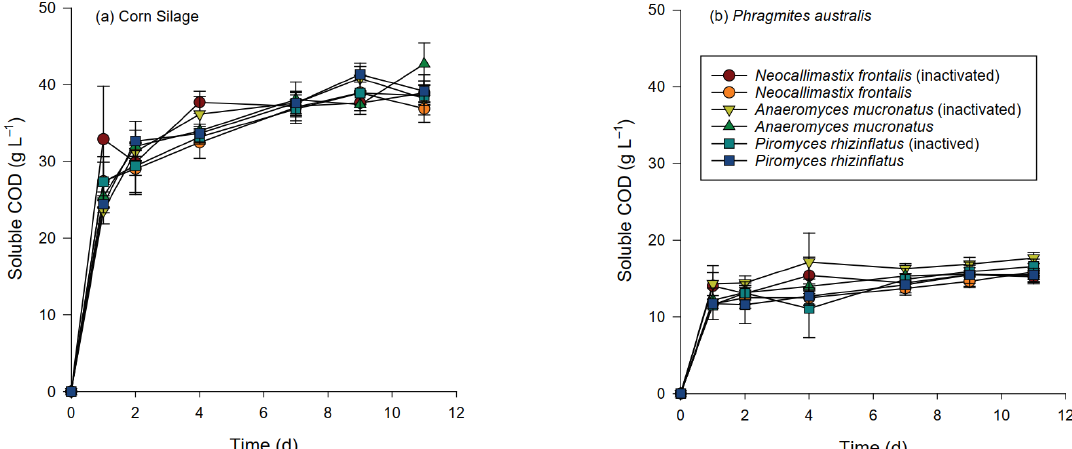
Figure 3. Soluble COD production in the bioaugmentation of three different anaerobic fungal species: ( a ) corn silage ( Zea mays L.); ( b ) common reed ( Phragmites australis ). Error bars show standard deviation.